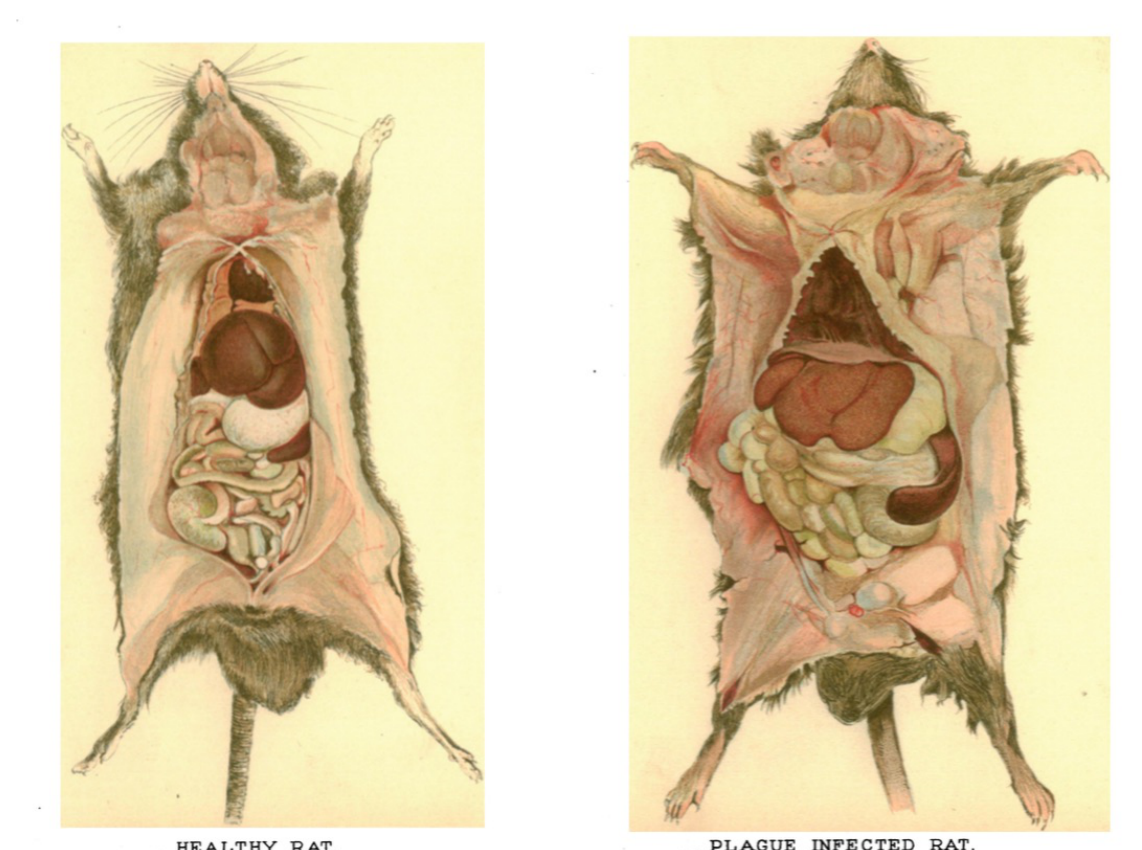
Figure 2. Drawings of healthy and infected rats pinned to the board and dissected Source: Edwin Wilson (illustrator) in Plague Commission (1907a), Plate